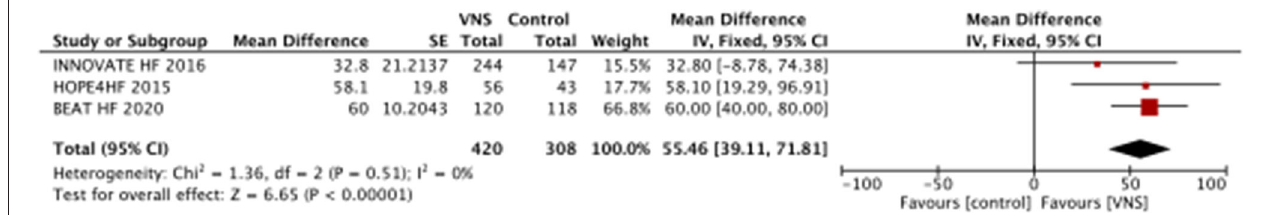
FIGURE 5 | Improvement of the 6-min walking test during follow-up between VNS and control groups for management of chronic heart failure with reduced ejection fraction. VNS, vagus nerve stimulation.